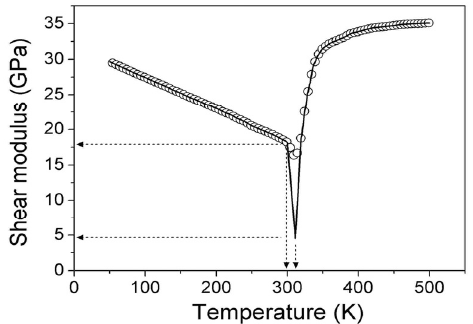
Figure 1. Experimental values of shear elastic modulus of the Ti (circles) and the extrapolation of experimental data used for computation of martensitic transformation (MT) strain (line). The arrows point to the characteristic MT temperatures and correspondent values of shear